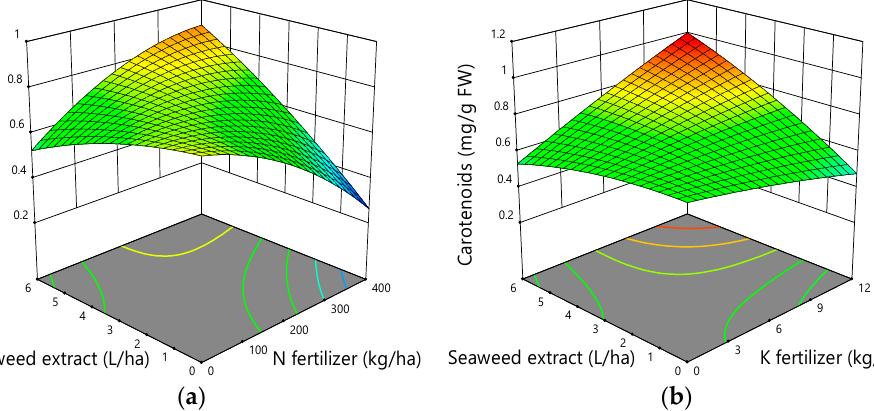
Figure 2. Response surface plots showing the effects of N fertilizer and seaweed extract ( a ), and K fertilizer and seaweed extract ( b ) on the carotenoids content of thyme. K fertilizer in ( a ), and N fertilizer in ( b ) was kept constant at 6 and 200 kg ha − 1 ,